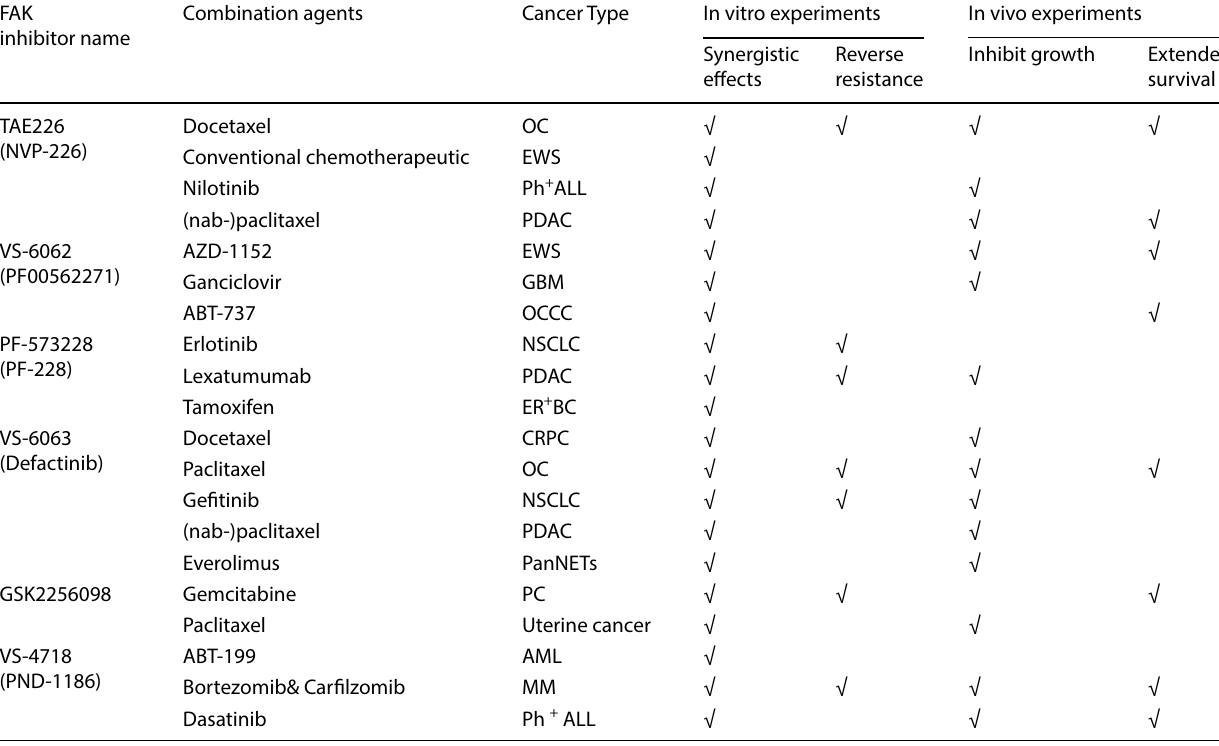
Table 2 Combination agents of ATP-competitive FAK inhibitor